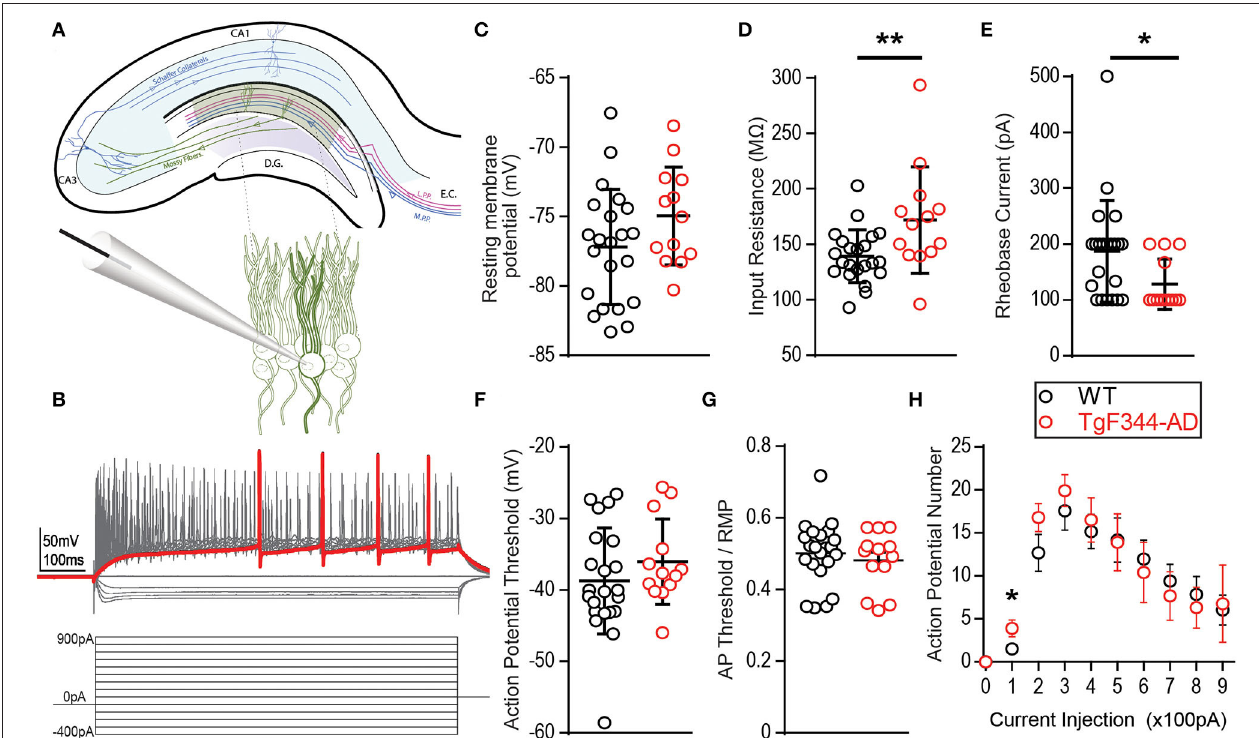
FIGURE 1 | Membrane properties are altered in TgF344-AD dentate granule cells (DGCs). (A) Schematic of the trisynaptic circuit in a coronal slice from rat hippocampus (top) with expanded recording setup (bottom). (B) Illustration of the experimental protocol: 14 serial 100pA hyperpolarizing to depolarizing current steps at 800ms duration from − 400pA to + 900pA. The red trace represents the first depolarizing current step to fire and action potential. (C) Mean resting membrane potential is not different between wild type (Wt) (black, 22 cells/8 animals) and TgF344-AD female rats (red, 13 cells/6 animals; p > 0.05, but a higher fraction in Wt has values below − 80mV). (D) Input resistance is significantly decreased in TgF344-AD DGCs (Wt n = 22 cells/8 animals; Tg, n = 13 cells/6 animals; ** p ≤ 0.01). Data represent mean ± SEM. Significance is determined using the unpaired t -test. (E) The first depolarizing current step to elicit and action potential, Rheobase (pA), is significantly decreased in TgF344 compared with Wt (* p < 0.05). (F) Action potential threshold is not different between genotypes ( p > 0.05). (G) When AP threshold is normalized to RMP, there remains no difference between genotype ( p > 0.05). (H) AP number was enhanced for TgF344-AD rat DGCs at 100pA current injection ( p < 0.05) but not at higher current injections. For all panels, Wt, n = 22 cells/8 animals; Tg, n = 13 cells/6 animals). Data represent mean ± SEM. Significance is determined using the unpaired Student’s t